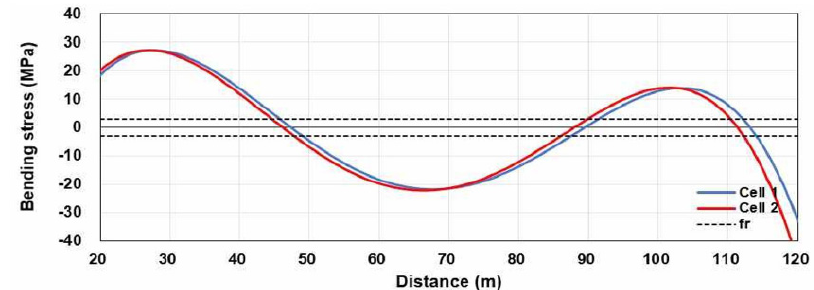
Figure 15. Comparison result of elastic beam analysis (bending stress).